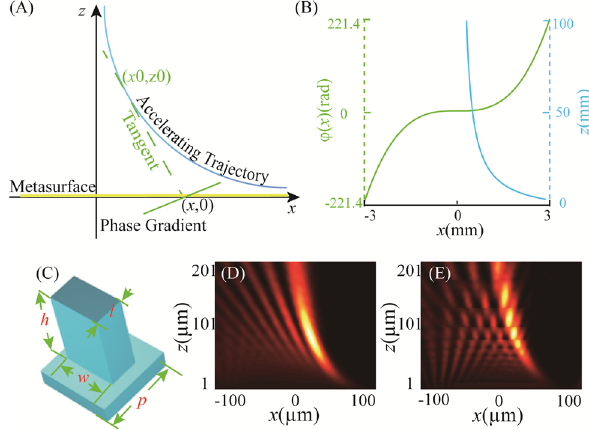
Figure 1: (A) Schematic diagram of deducing phase distribution for generating the self-accelerating beam trajectory based on geometrical optical framework. (B) Reciprocal self-acceleration trajectory (blue) and the phase distribution (green)of the generator. (C) Schematic illustration of the rectangular antenna. (D, E) Simulated trajectories of the discrete metasurfaces whose lattice constants are 0.1 λ and 0.7 λ ,